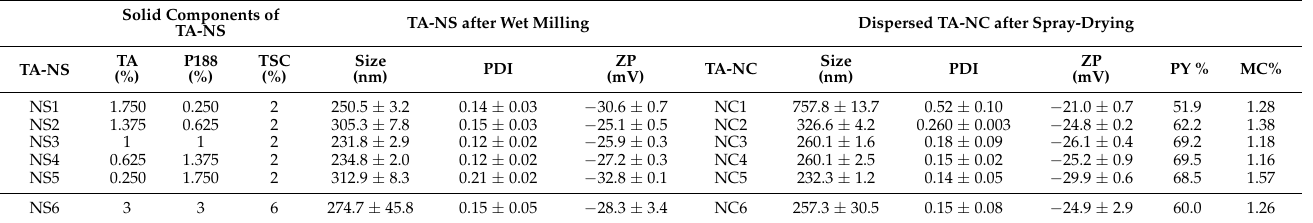
Table 1. Composition and colloidal parameters of triamcinolone acetonide nanosuspensions (TA-NS) and self-dispersible triamcinolone acetonide nanocrystals (TA-NC) obtained by bead milling and spray-drying,